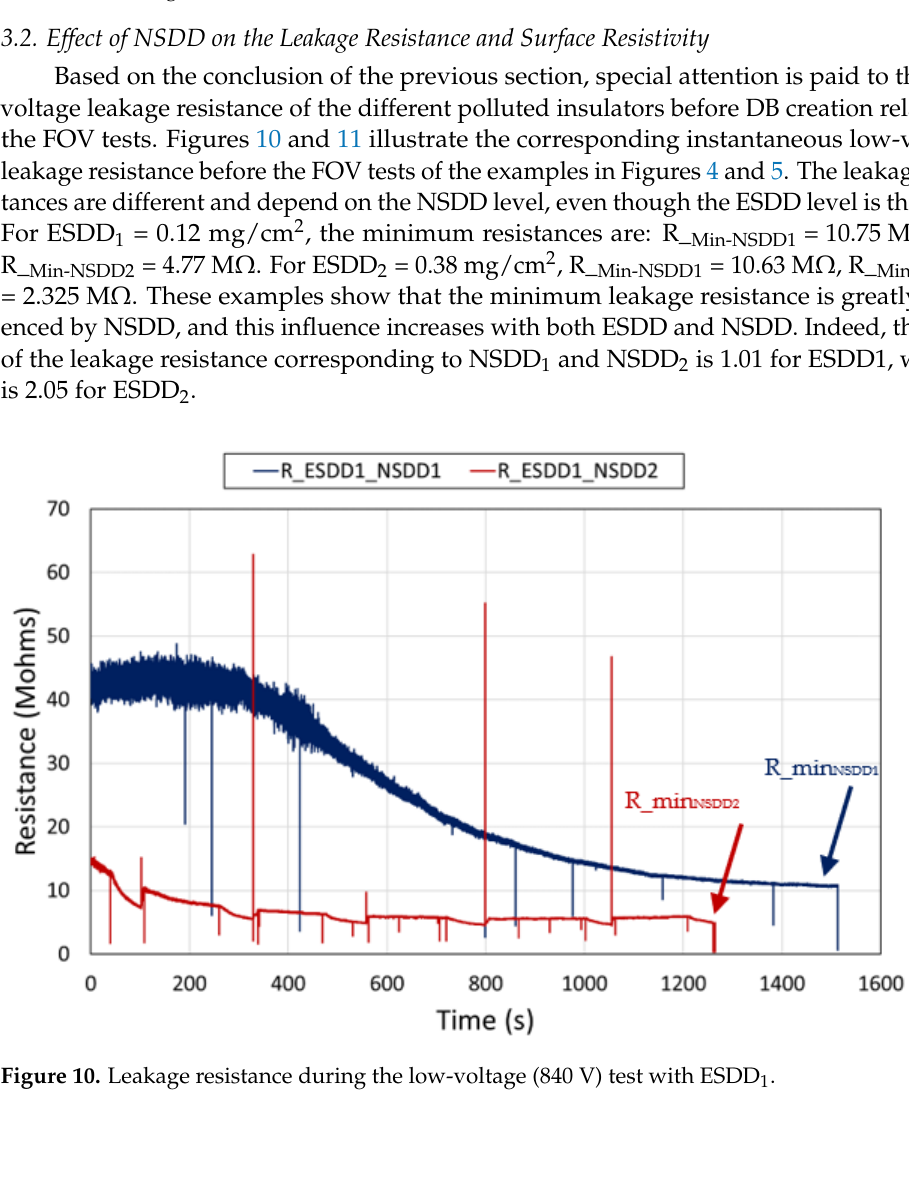
Figure 9. Visual observation of DbDs and DBAs activity with ESDD 1 = 0.12 mg/cm 2 and NSDD 2 = 0.23 mg/cm 2 .